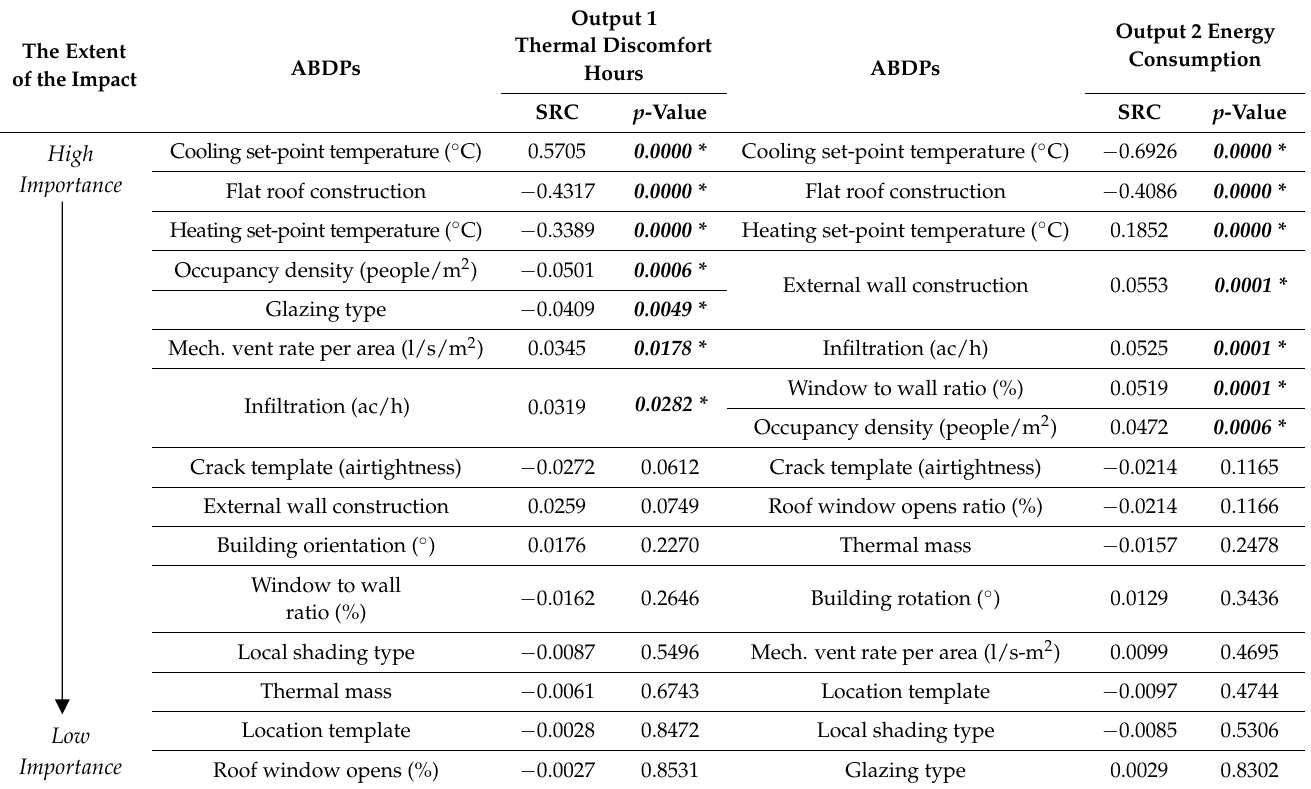
Table 3. The relative importance of the different variables based on regression analysis.